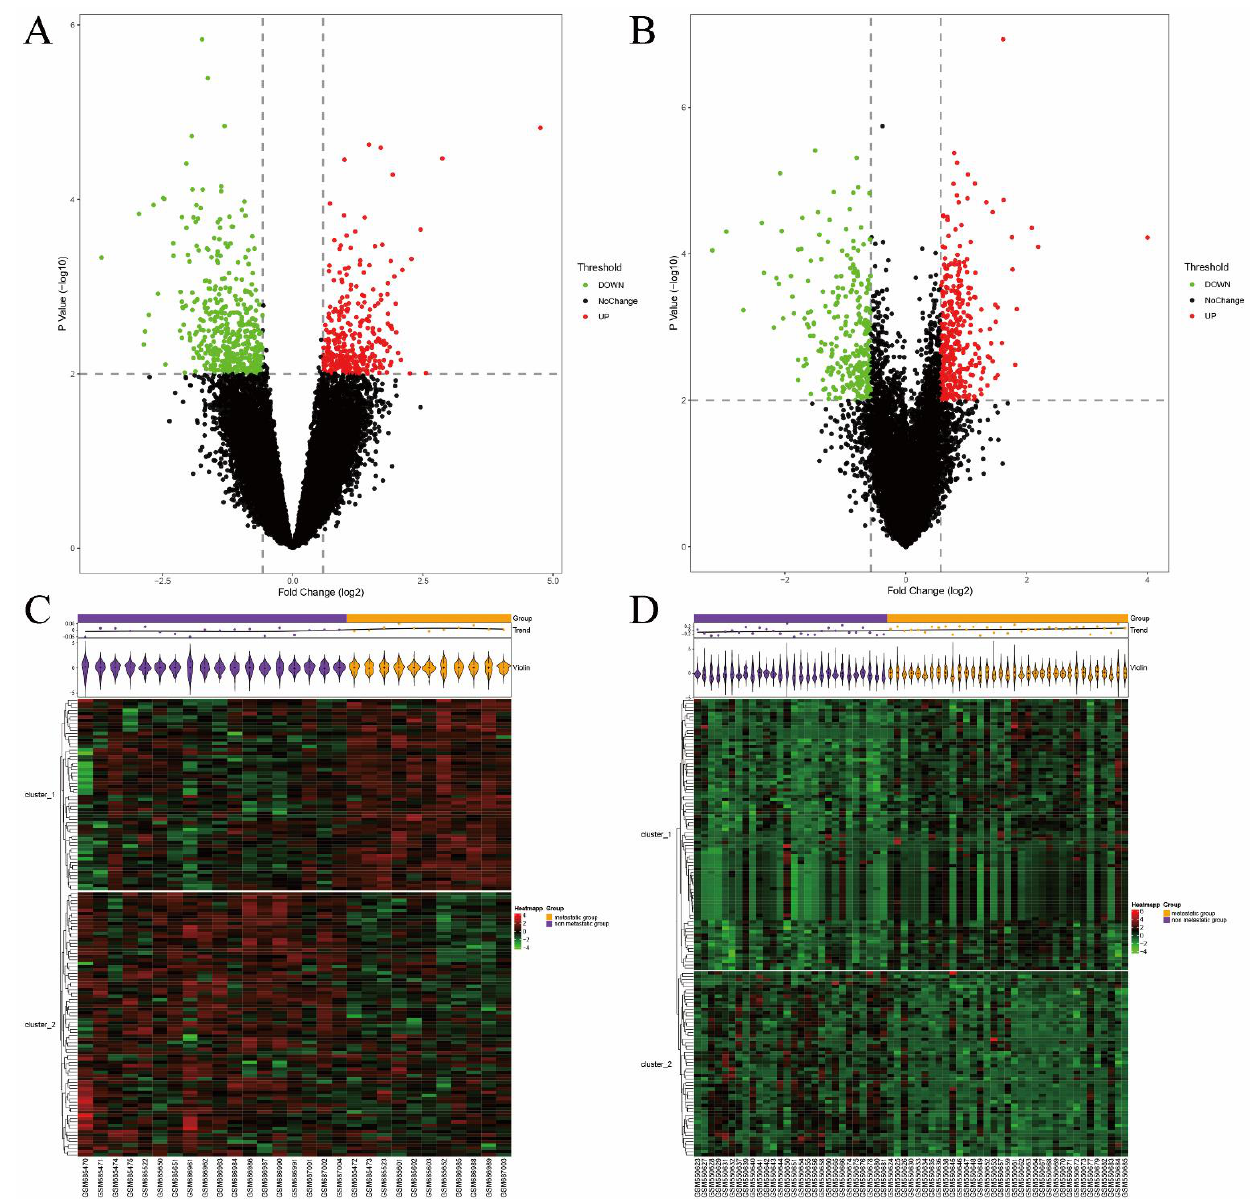
Figure 1. Volcano plots of differentially expressed genes in ( A ) GSE27831 and ( B ) GSE22138. Data points in red represent upregulated genes, and green represents downregulated genes. The differences were set as p < 0.01 and |log FC| > 0.58. Heatmap of differentially expressed genes identified in ( C ) GSE27831 and ( D ) GSE22138. The legend on the top right indicates the log fold change of the genes.